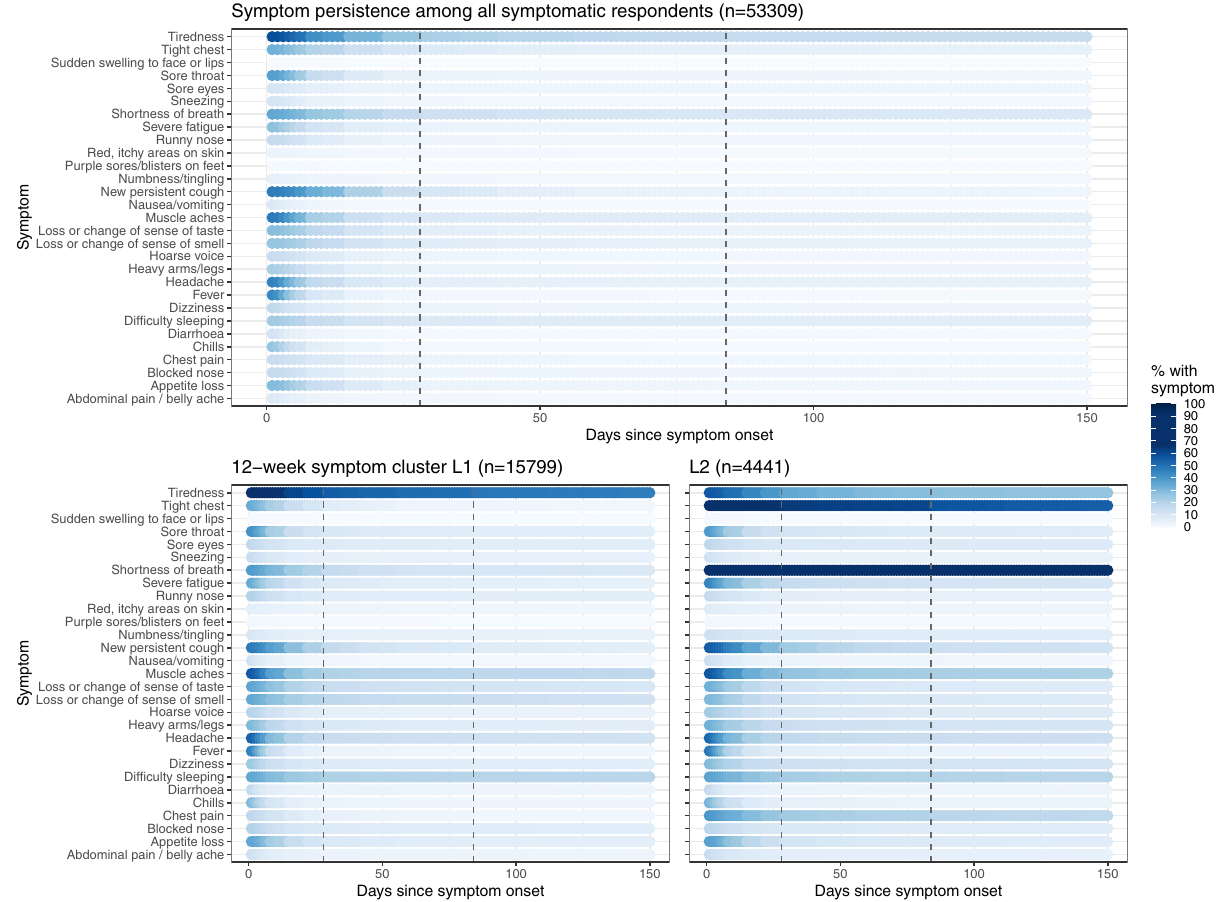
Fig. 6 Persistence of individual symptoms, by symptom cluster. Persistence of symptoms for all symptomatic participants (top panel) and in 12-week symptoms clusters L1 and L2 (bottom panels). Dashed lines show 4 and 12 weeks post symptom onset,